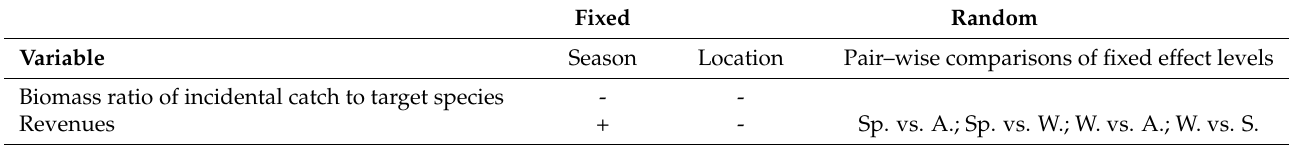
Pair–wise comparisons of fixed effect